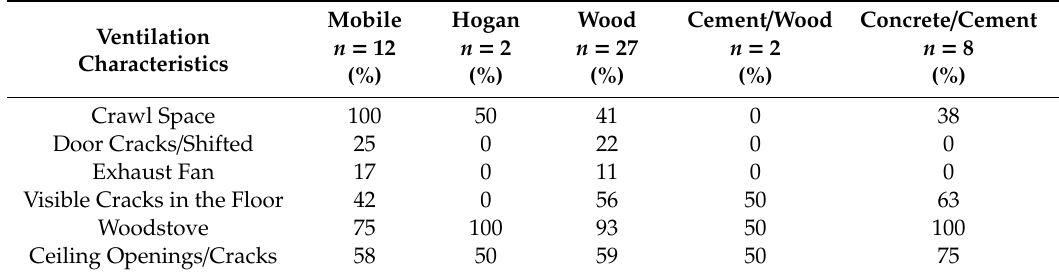
Table 2. Basic Ventilation Characteristics by House